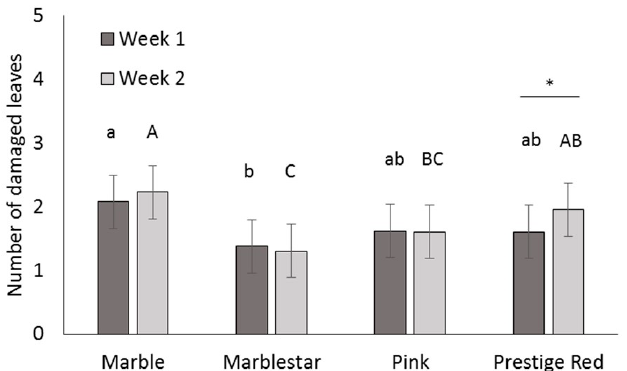
Figure 2. Phytotoxicity (mean ± SE of damaged leaves per cutting) of cutting dips on four greenhouse poinsettia varieties, one and two weeks after dipping. Different lowercase letters indicate significant differences among varieties one week after dipping, different uppercase letters indicate significant differences among varieties at week 2. Asterisk indicates a significant difference between week 1 and 2. ( α = 0.05).